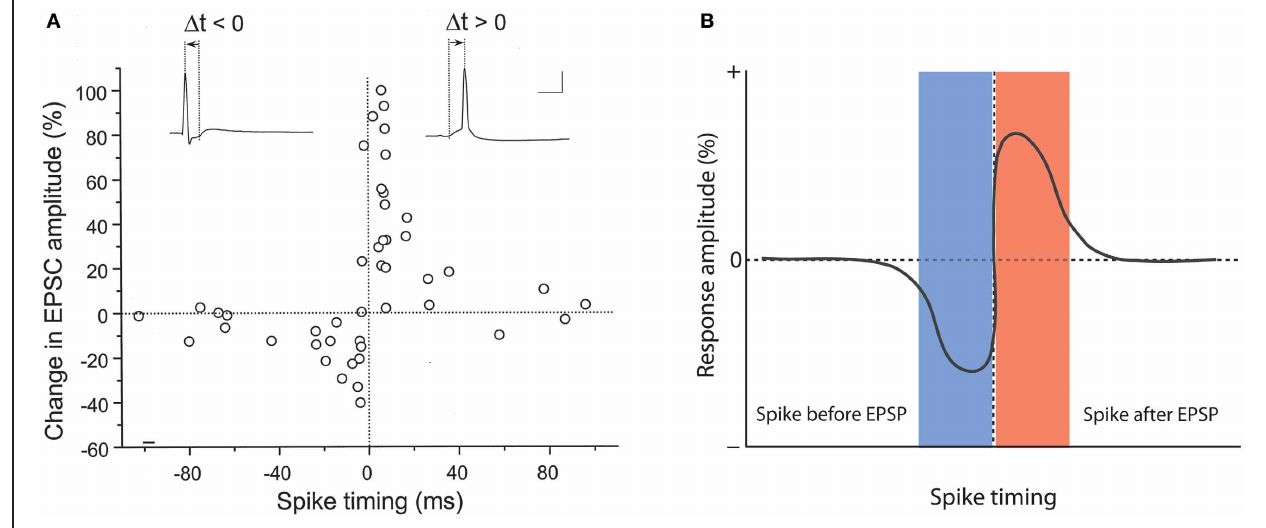
FIGURE 1 | Hebbian-style STDP in hippocampal neurons. (A) Temporal order for the induction of LTP and LTD at glutamatergic synapses onto cultured rat hippocampal neurons. The change in EPSC amplitudes measured at 20–30min after tetanization (60 stimuli at 1Hz) is plotted against spike timing. Spike timing is defined by the time interval ( (cid:2) t ) between the onset of